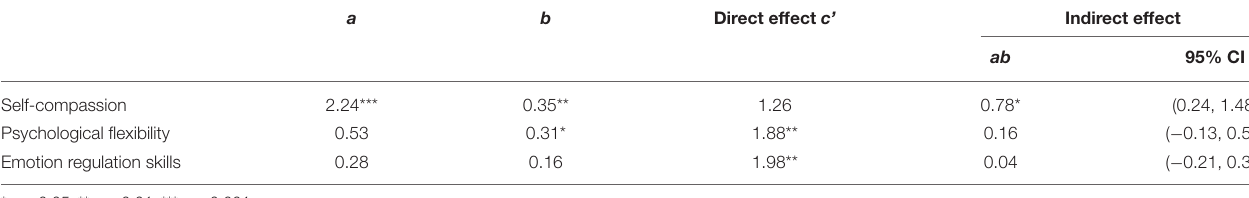
TABLE 4 | Multilevel coefficients and indirect effects for mediation of psychological processes on positive mental health in the intervention group.